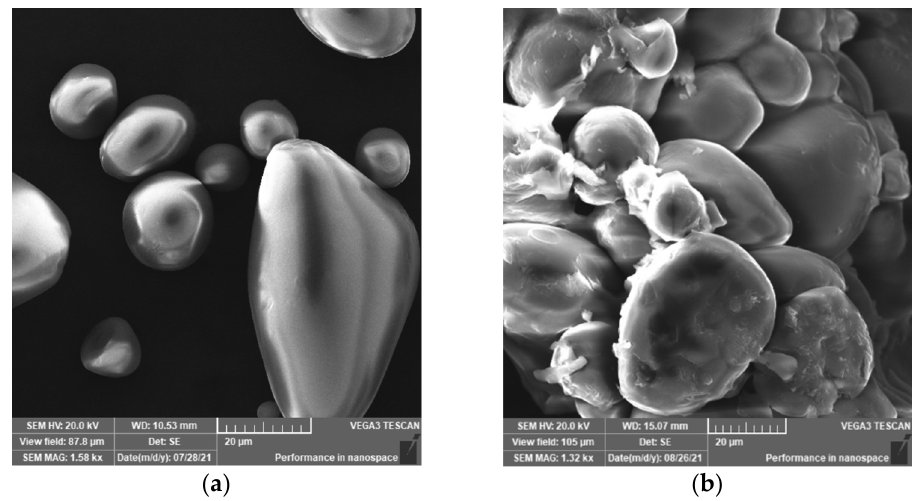
Figure 9. SEM images obtained for ( a ) pure starch and ( b ) St-g-(MA-DETA).